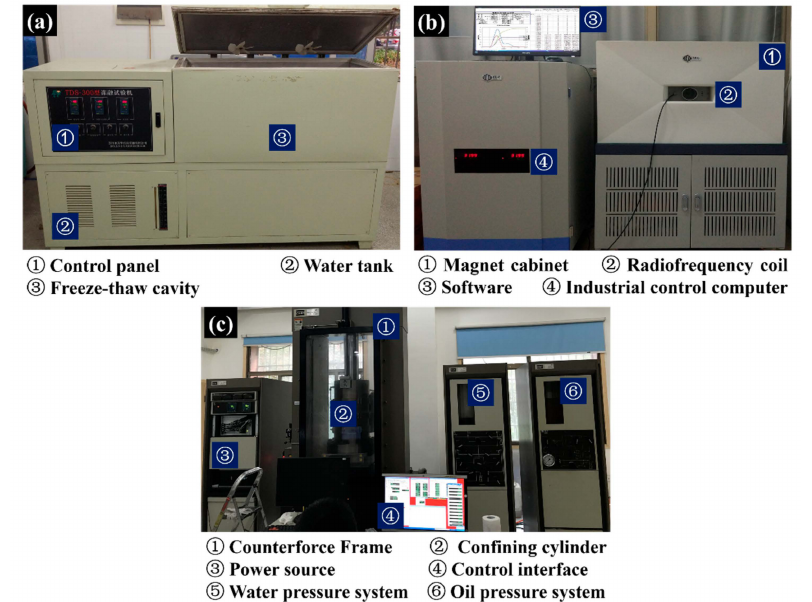
Figure 3. Experiment instrument: ( a ) TDS-300 automatic freeze–thaw test machine; ( b ) MesoMR23- 060H-I NMR system; ( c ) MTS815 electrohydraulic servo-controlled rock-testing